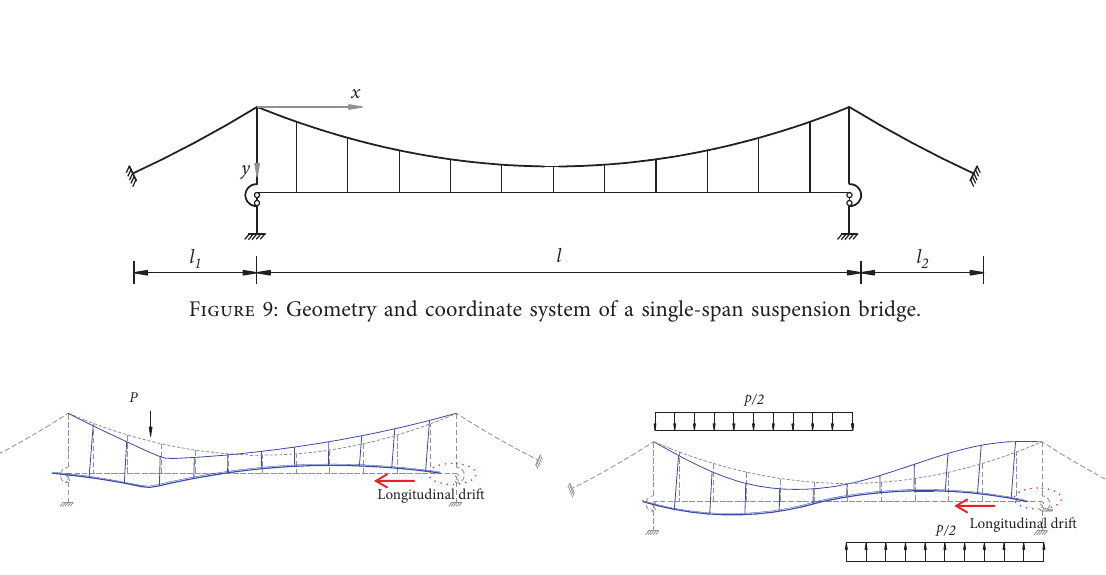
Figure 8: Fourier spectrum curve of 10min longitudinal displacement at the girder end.